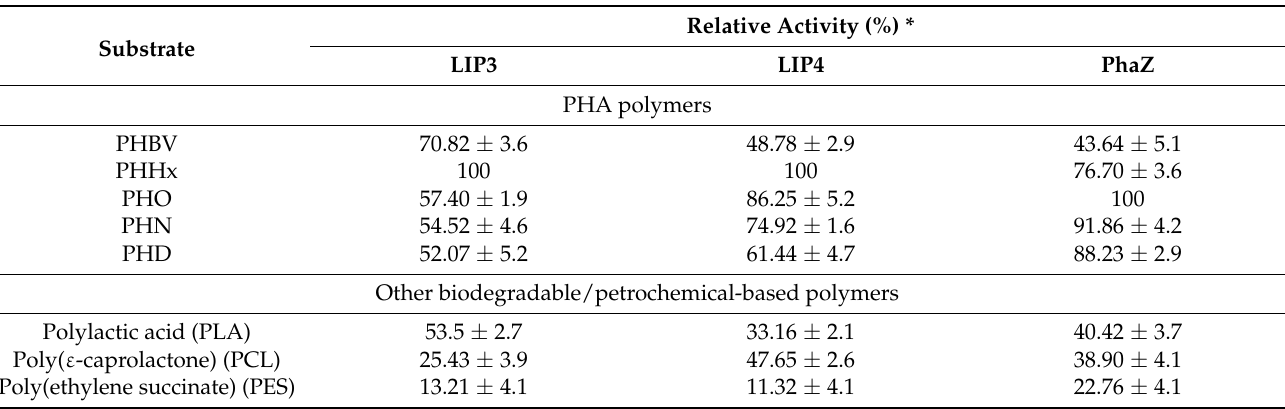
* Values shown are the averages of three independent (biological) replicate experiments ± standard deviations. The pure enzyme (0.025 mg) was tested with the indicated substrates at a final concen- tration of 1 mg for 96 h in all cases. The polymer without enzyme was used as a control. The maximum observed activity was set at 100%. Activity of100% corresponded to 207.41 U mg −1 in LIP3, 114.09 U mg −1 in LIP4, and 650.13 U mg −1 in PhaZ.